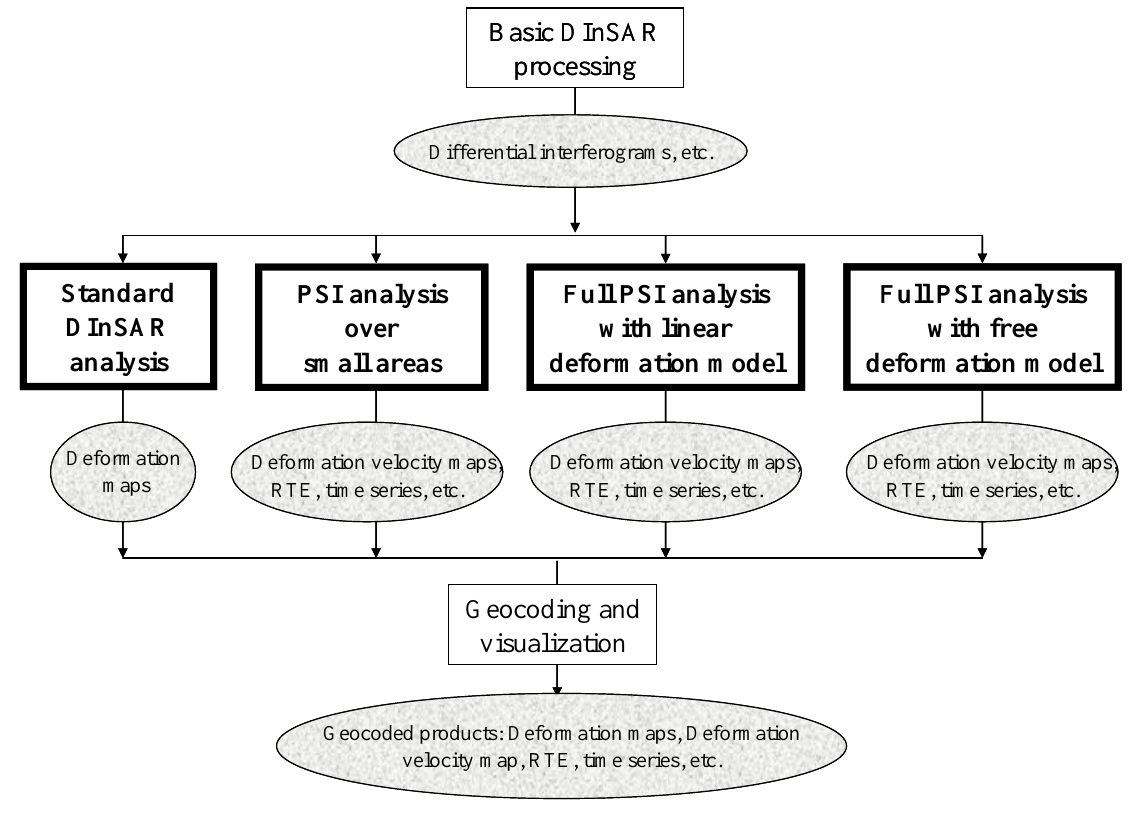
Figure 1. General scheme of the different DInSAR data analysis procedures used at IG. Basic